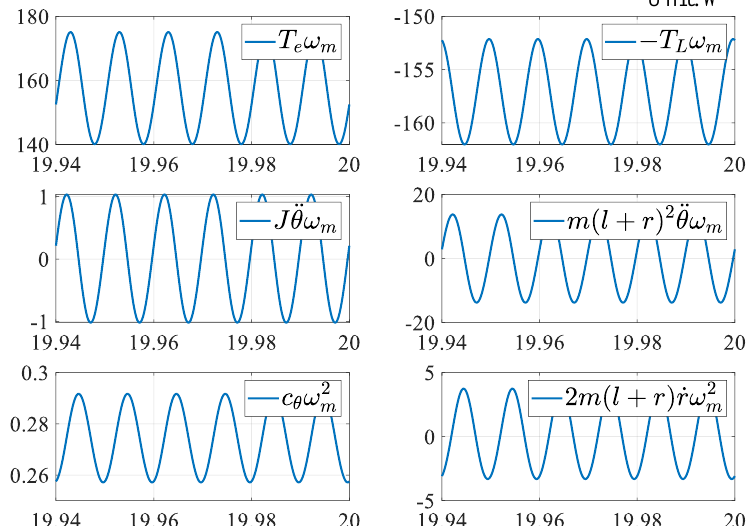
Figure 10. Mechanical energy flow for motor.